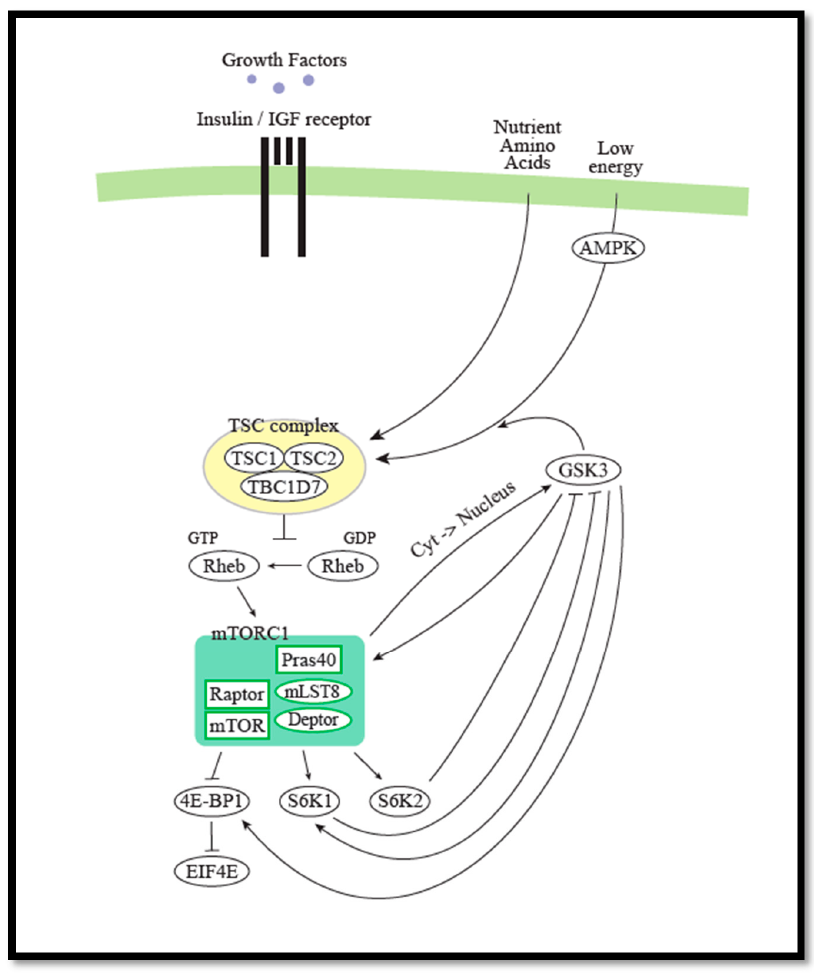
Figure 5. GSK3 in Hh and mTOR crosstalk. GSK3 inhibits Hh signaling by phosphorylation of GLI transcription factors, leading to their degradation. Upon an AMPK-mediated priming phosphorylation of TSC2, GSK3 β could phosphorylate and activate TSC2, leading to inhibition of mTORC1. Inhibition of mTORC1 was demonstrated to change the cellular distribution of GSK3 β from the cytosol to the nucleus. In contrast, GSK3 β activates mTORC1, through direct phosphorylation and stabilization of Raptor. GSK3 β also positively regulates S6K1 and negatively regulates 4E-BP1, by phosphorylation, in both cases leading to increased protein synthesis. S6K2 and S6K1 could both inhibit GSK3 β through p.Ser9 phosphorylation.